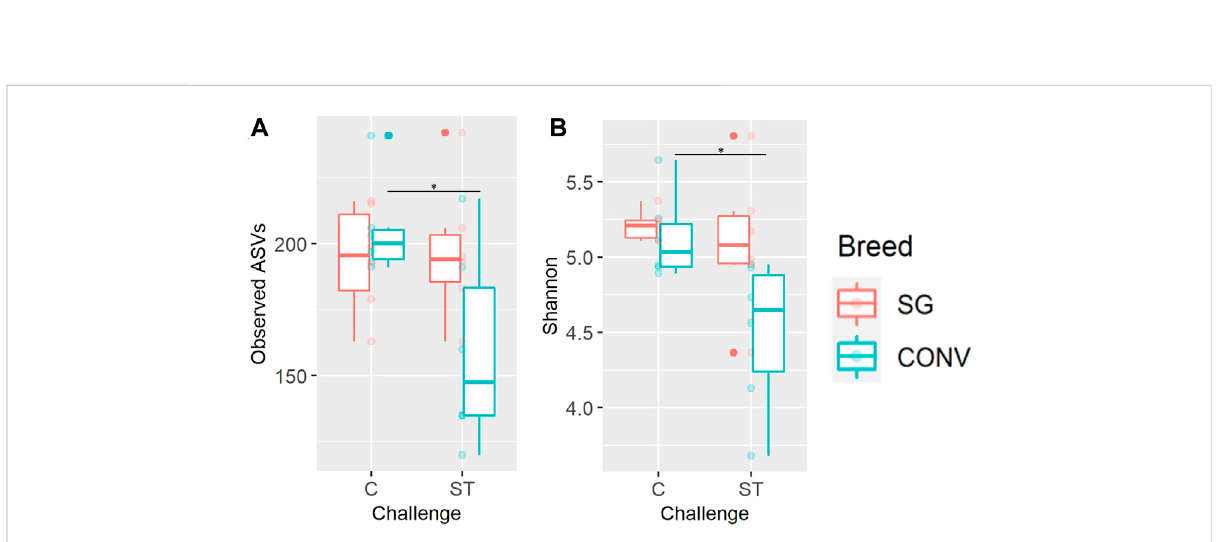
FIGURE 9 The interaction between of genetic line and Salmonella challenge on the cecal observed amplicon sequence variant (ASV) richness (A) and Shannon diversity (B) for 17-day-old broilers. The presence of an asterisk indicates a signi fi cant difference between pairwise groups in which * corresponds to p < 0.05, ** corresponds to p < 0.01, and *** corresponds to p < 0.001. Control (C) and Salmonella Typhimurium challenged (ST)